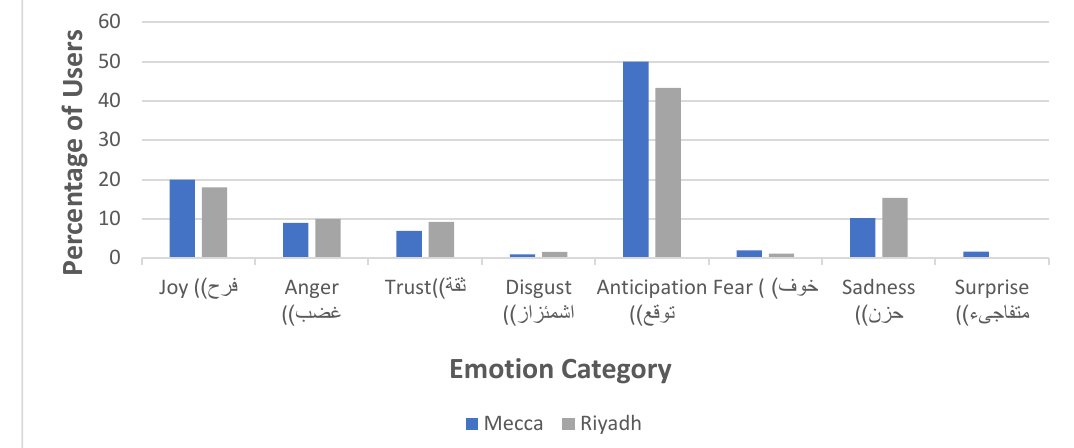
Figure 3. Eight emotion words [37].